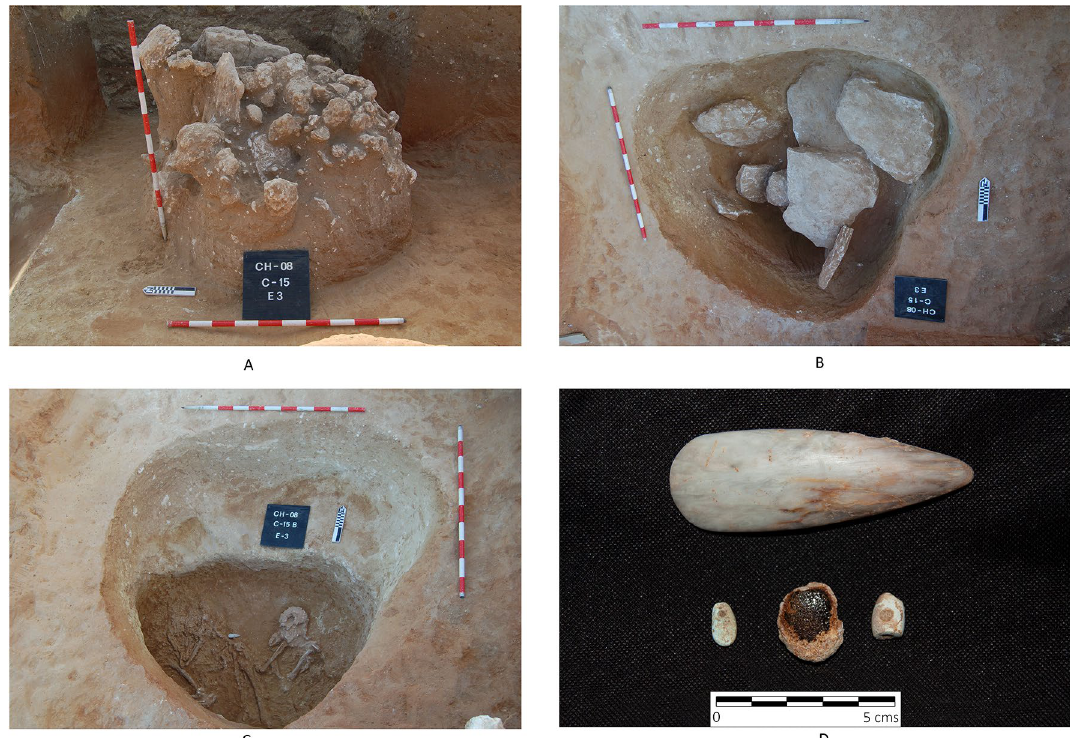
Figure 13. Burial E3C15 (Type VII) during excavation: ( A ) Stone mound that covered the feature; ( B ) Stone slab covers under the mound; ( C ) Burial level, with an individual on its right side; and, ( D ) grave goods, including a sillimanite axe; an amber pendant; a variscite bead; and a turquoise